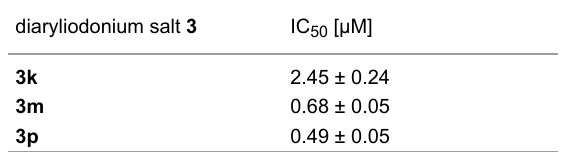
Figure 3: X-ray crystallographic structure of 3p drawn at 50% probability (CCDC 1573953).